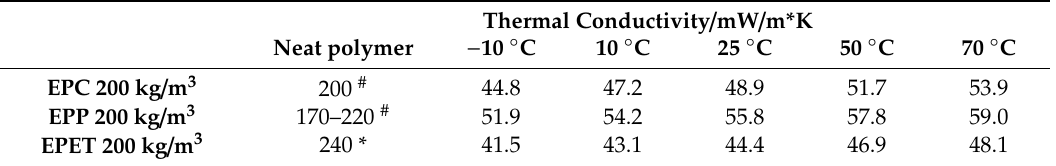
Table 6. Full data for thermal conductivity investigation for EPC, EPP, and